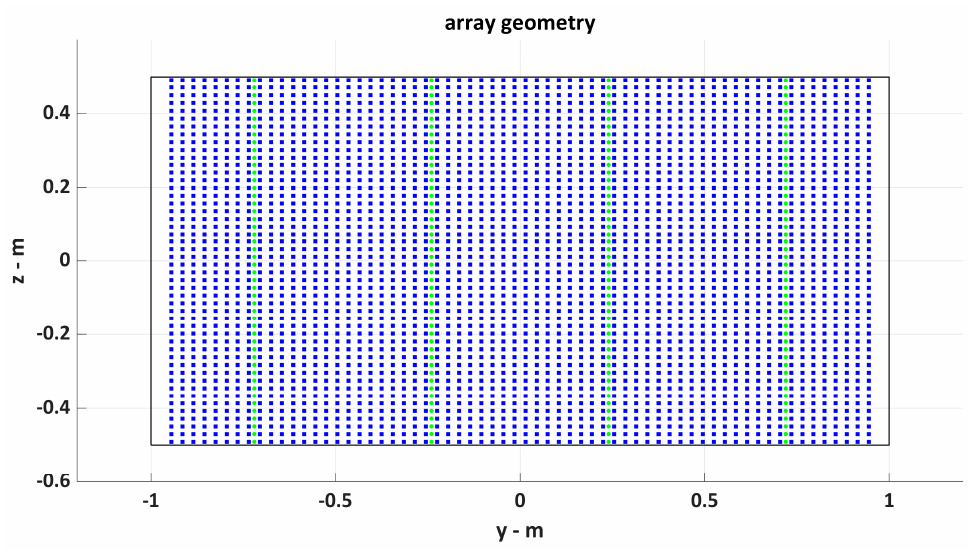
Figure 17. Array geometry of the S-STEP SAR antenna model.